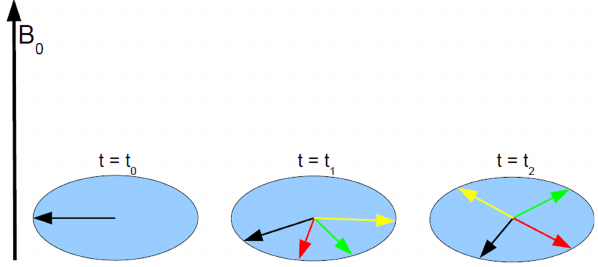
Fig. 1. Loss of phase coherence of protons due to differences in the Larmor frequency in the presence of magnetic